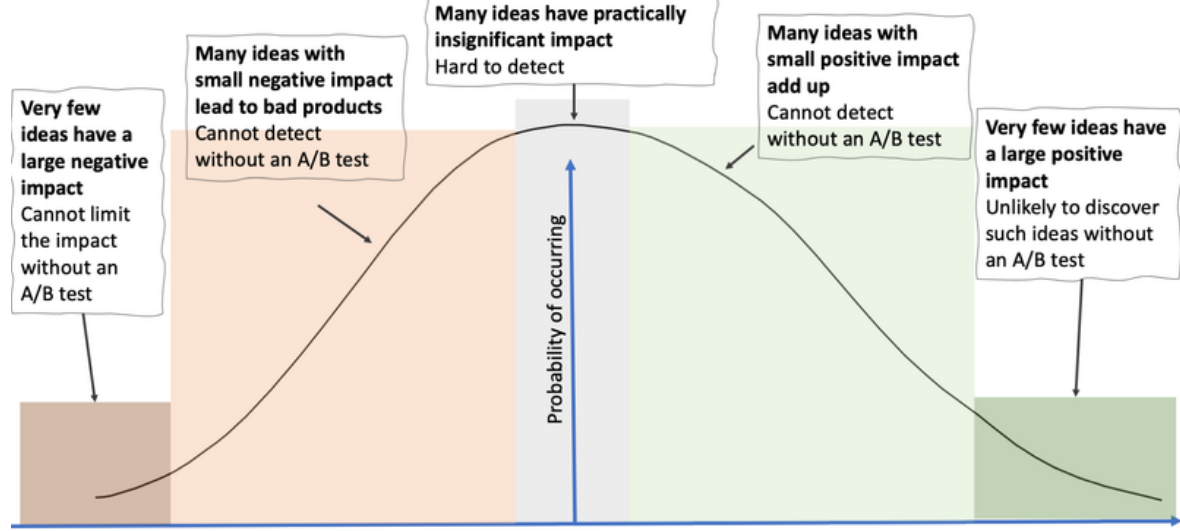
Figure 2. Hypothetical distribution of return on investment for ideas generated in a